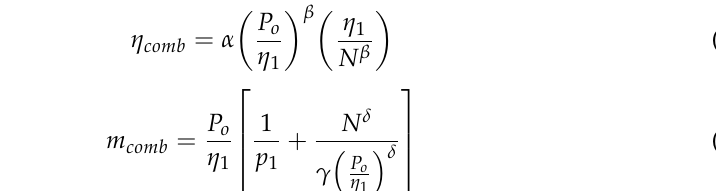
Figure 10. Combined mass and efficiency of two-branch system with non-constant component parameters.